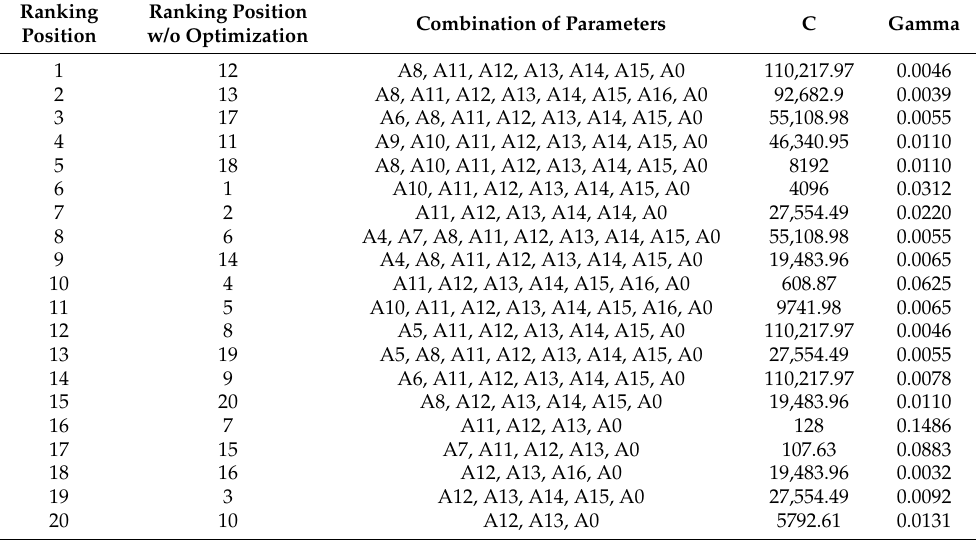
Table 5. Top 20 ranking for multiple wavelength usage for white eggshells with hyperparameter